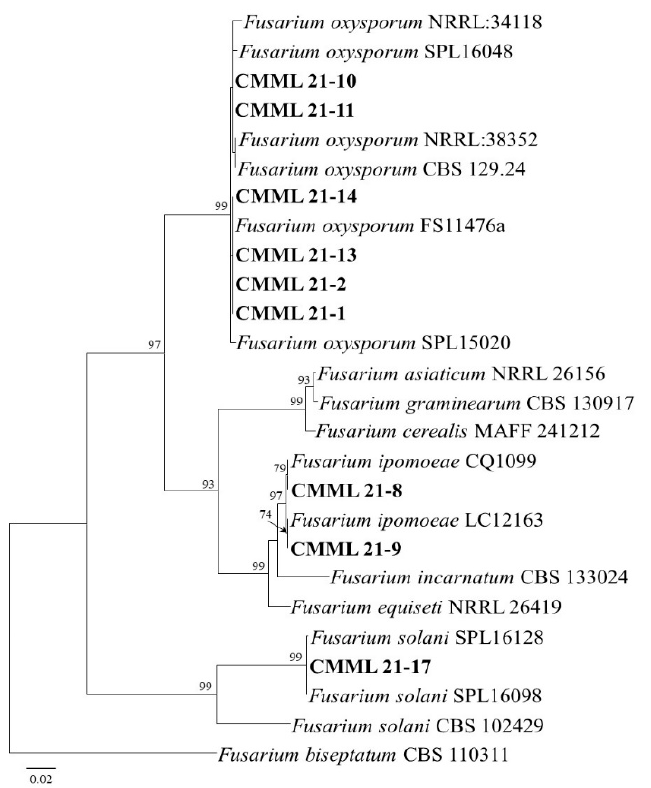
Figure 2. Maximum likelihood tree of the Fusarium isolates (CMML21–1, CMML21–2, CMML21–8, CMML21–9, CMML21–10, CMML21–11, CMML21–13, CMML21–14, and CMML21–17) inferred from the combined data sets of the ITS and EF1– α gene sequences constructed by the MEGA X program. The tree is rooted to F. biseptatum CBS 110311. Numbers on the branches indicate the bootstrap values. The scale bar indicates expected changes per site. The isolates from the present study are indicated in bold.